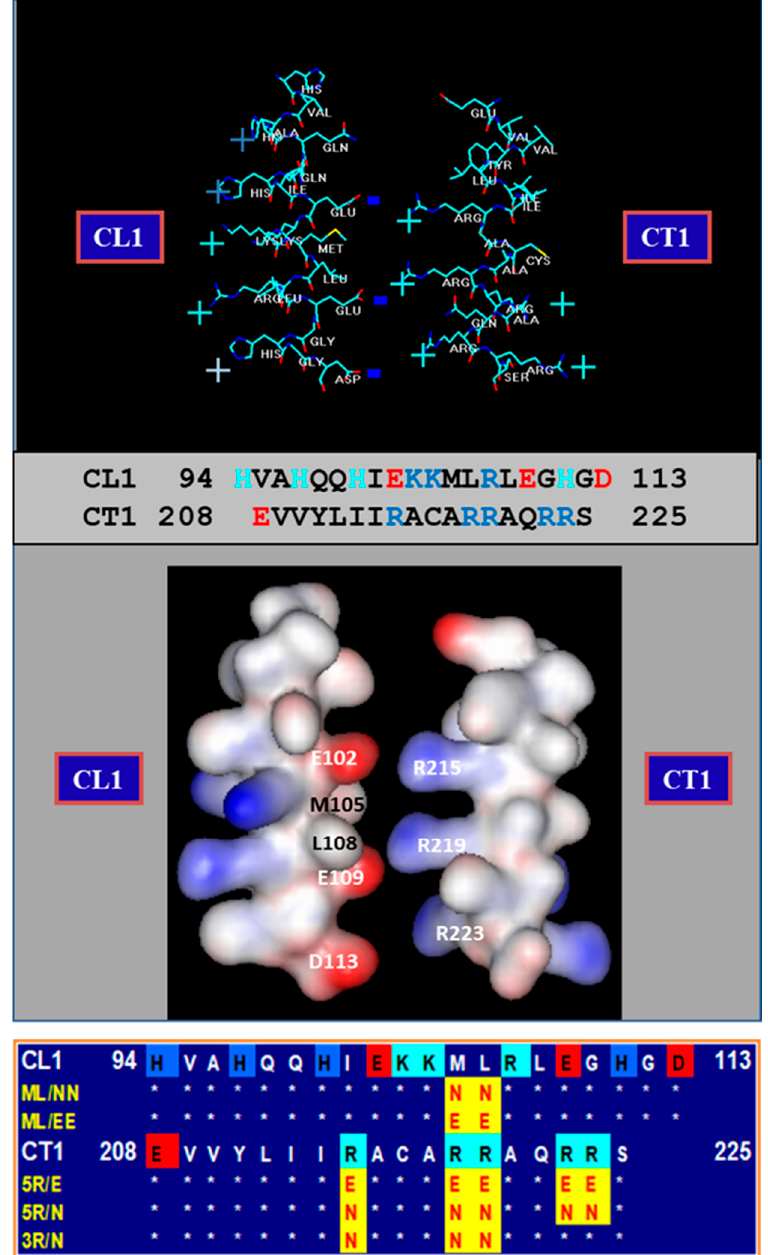
Figure 14. Cx32 ′ s CL1 (first half of CL) and CT1 (initial domain of CT) domains in α -helical conformation. Our hypothesis is that in coupled conditions CL1 and CT1 interact electrostatically (negative CL1, positive CT1) and hydrophobically. CL1 and CT1 mutation (bottom panel) are believed to prevent the interaction allowing the negatively charged CaM’s N-lobe to access the positively charged channel’s mouth and plugging it by interaction with it electrostatically (CaM-Cork model). We suggest that with an increase in [Ca 2+ ] i the activated CaM’s N-lobe accesses the gating site and plugs the channel’s mouth by breaking the CL1-CT1 interaction (Ca-CaM-Cork model).